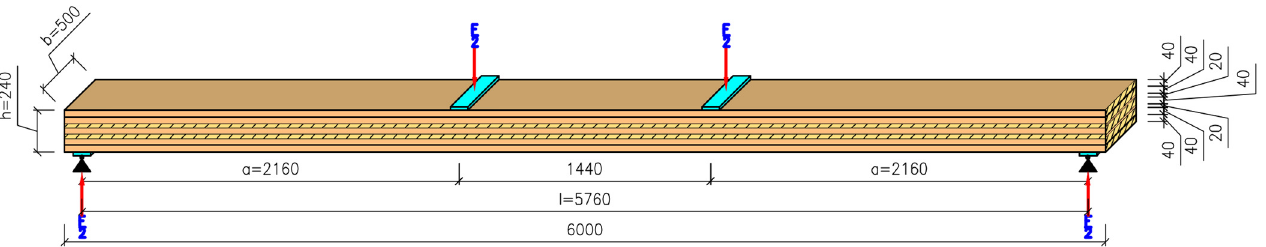
Figure 4. Test arrangement and geometry of CLT